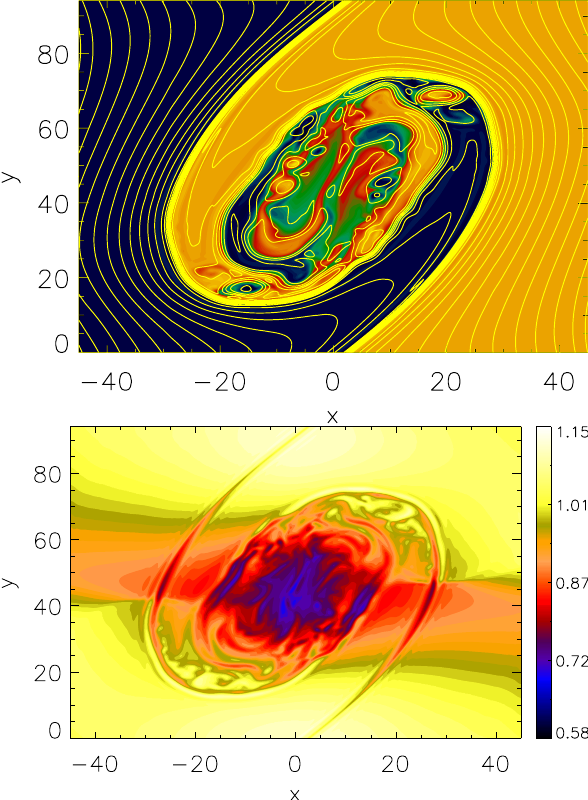
Fig. 10. Shaded isocontours of the passive tracer (top frame) and of the density (bottom frame) at t = 350, V 0 = 2. From the left to the right side along the x-axis, the passive tracers, purely advected by the velocity field, represent the magnetospheric (blue) and magne- tosheath (yellow) plasma separated by the transition region (green and orange). Yellow curves in the top frame represent the magnetic field lines in the